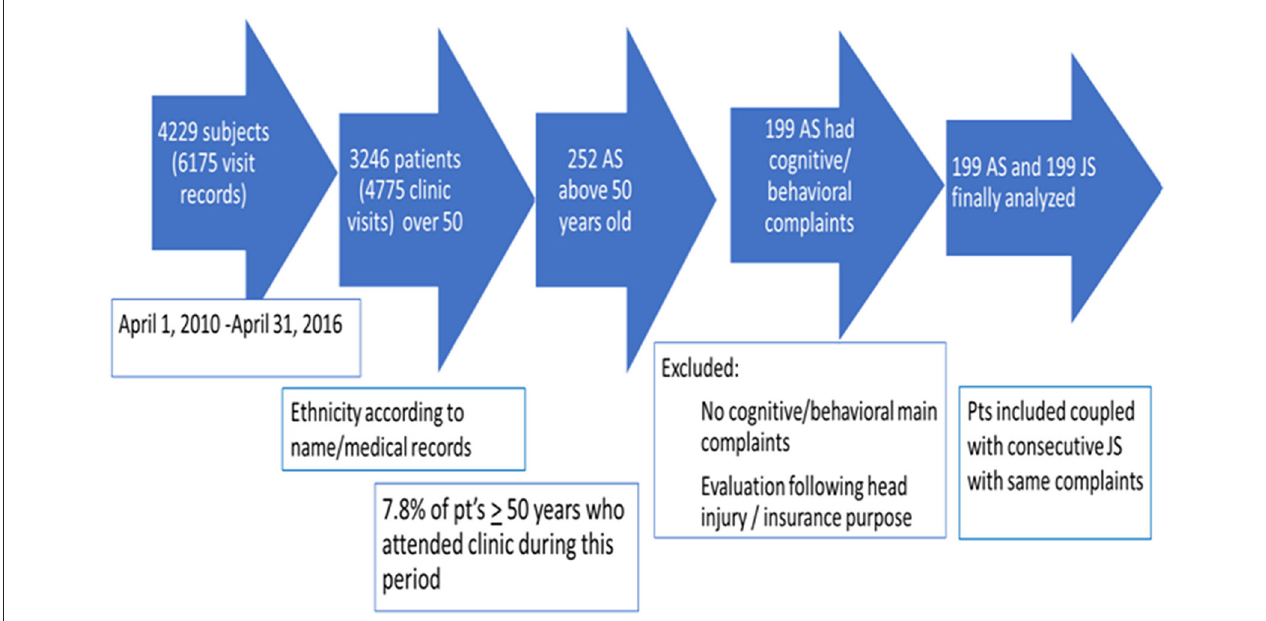
FIGURE 1 | Final enrolment in the study. Pt’s, patients.